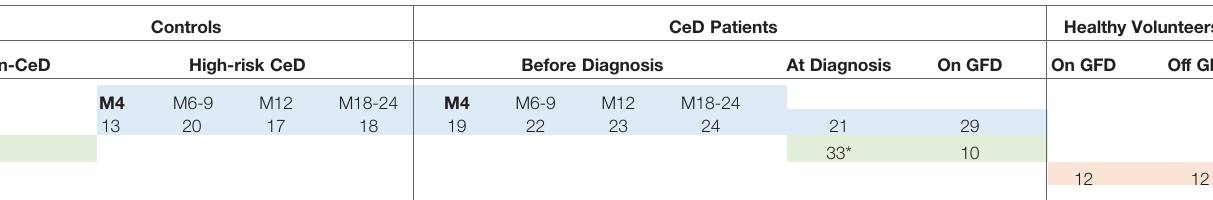
TABLE 1 | Overview of